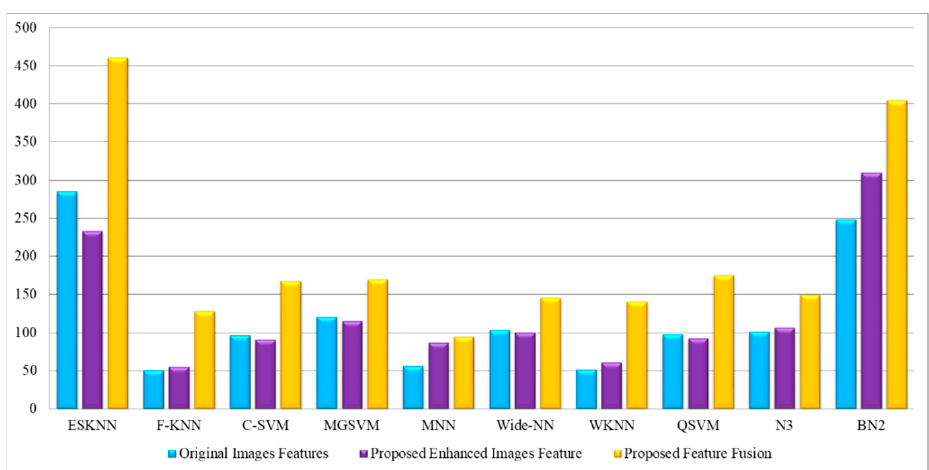
Figure 9. Comparison of proposed fusion step in terms of computational time with Tables 2 and 3. Table 5. Classification of CBIS-DDSM using the proposed feature selection